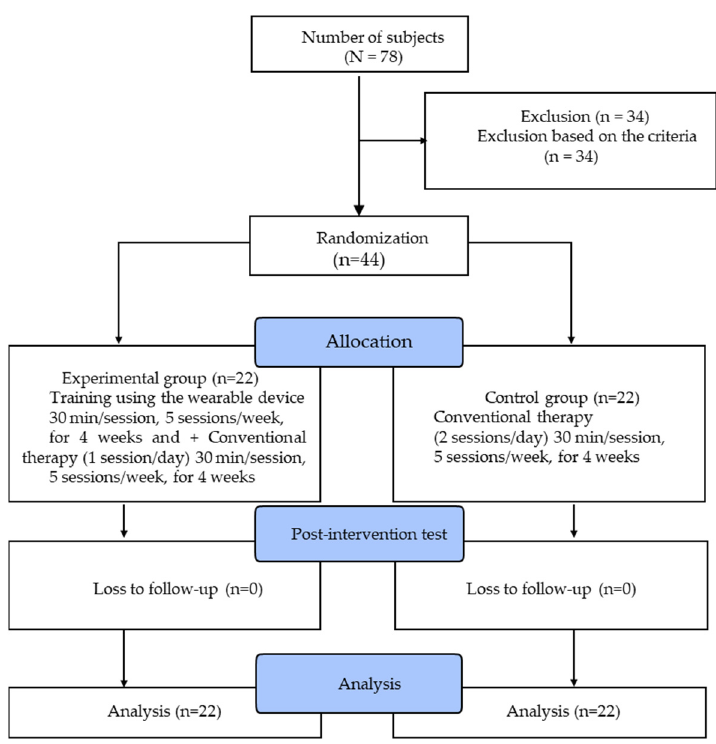
Figure 1. Experimental procedures.